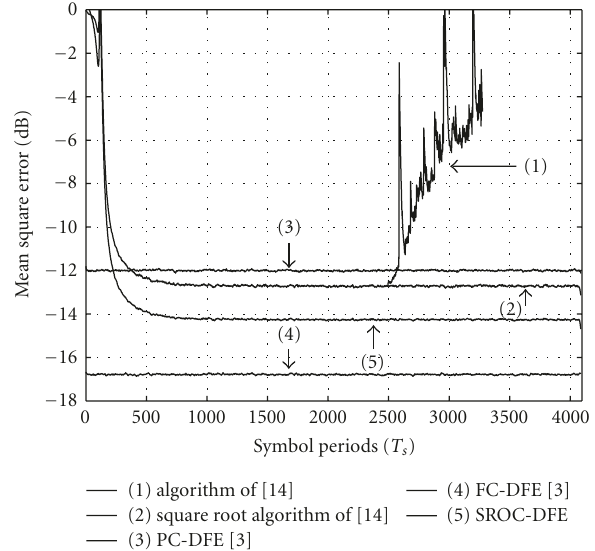
Figure 2: Convergence and steady-state performance of equalizers for a 4 × 4 system operating constantly in training mode over a static frequency-selective MIMO channel at SNR = 16dB.